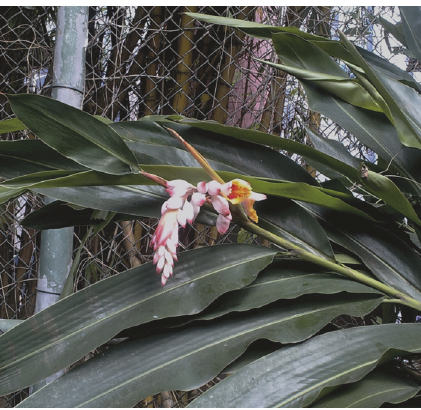
Figure 1: Alpinia zerumbet (Pers.) Burtt & Smith.